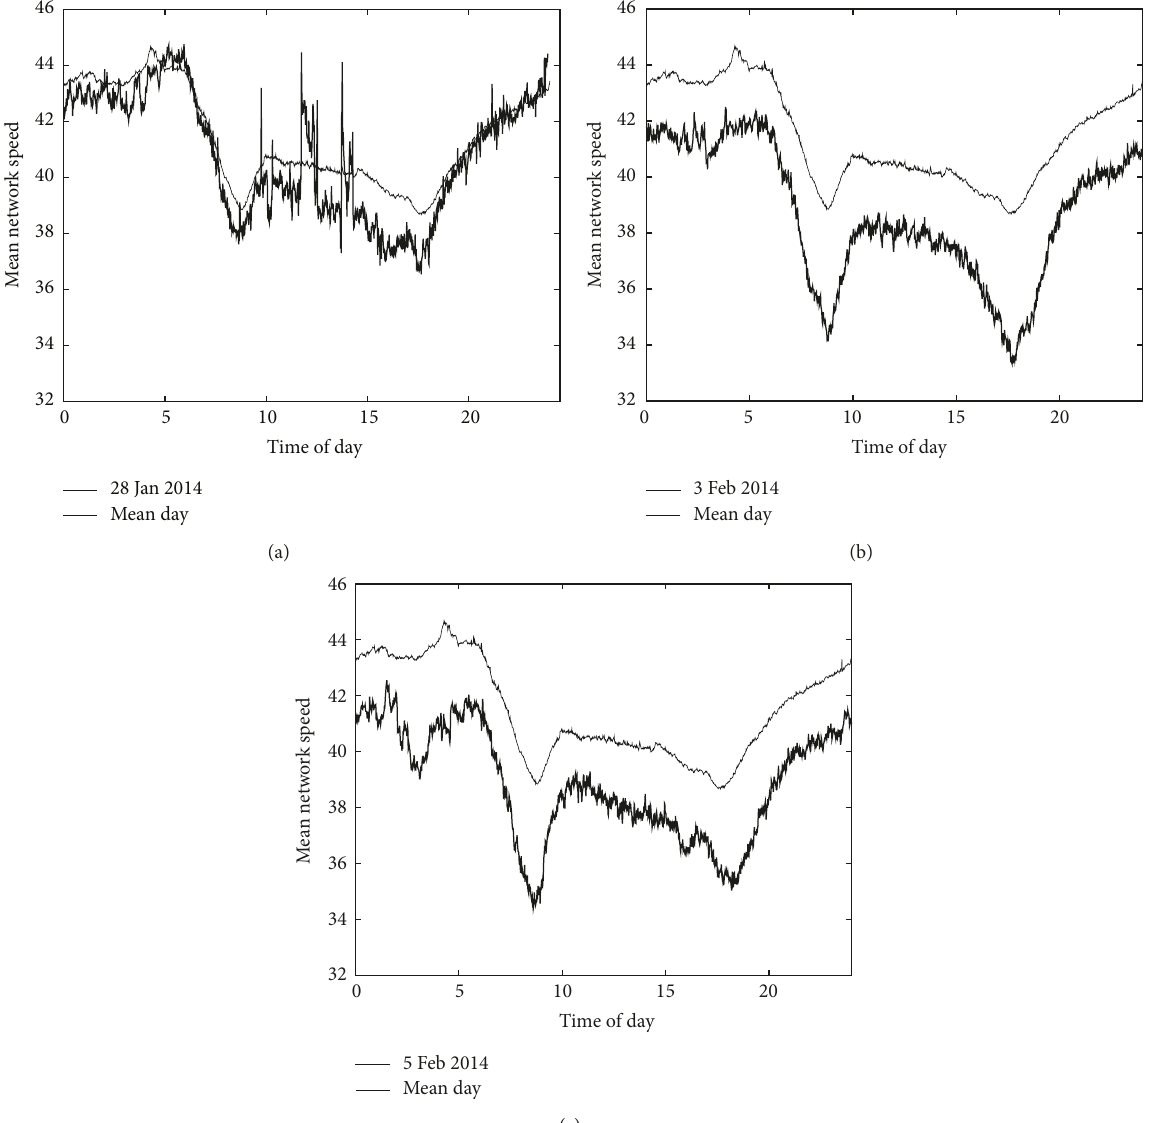
Figure 9: Selected day with an average speed pattern (a), a day with an abnormal speed pattern February 3, 2015 (b), and a day with an abnormal speed pattern on February 5, 2015